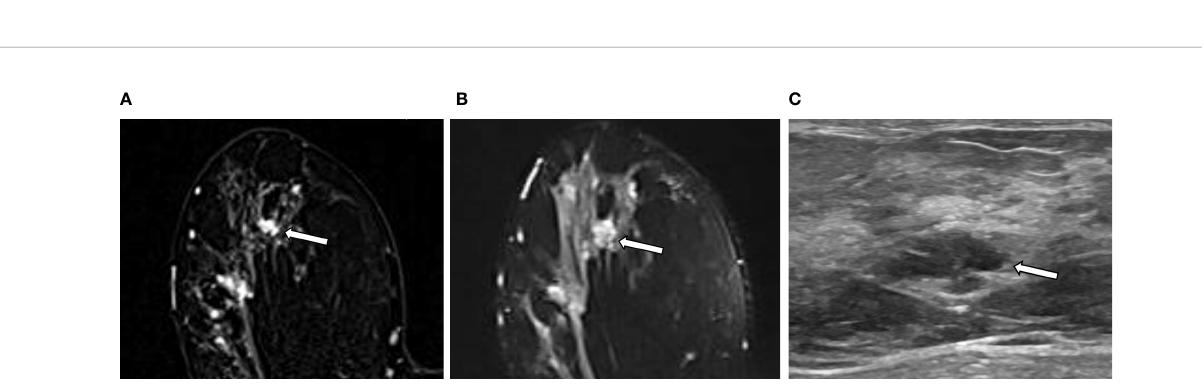
FIGURE 3 | Receiver operative characteristic curves of radiomics analysis (RA), clinical imaging interpretation (CII), and fusion models for SUB (A) , T2 (B) , and SUB +T2 (C) . SUB, images obtained by subtracting pre- from the fi rst postcontrast image; T2, T2-weighted image.